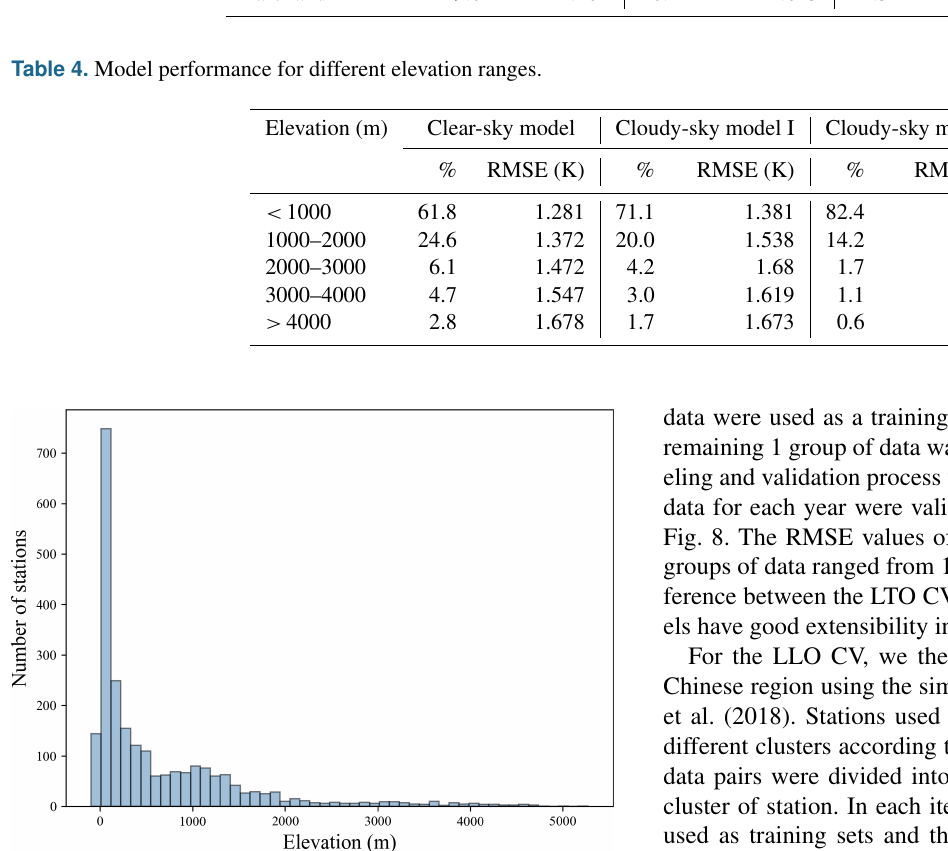
Figure 7. Elevation histogram of stations used in this study.